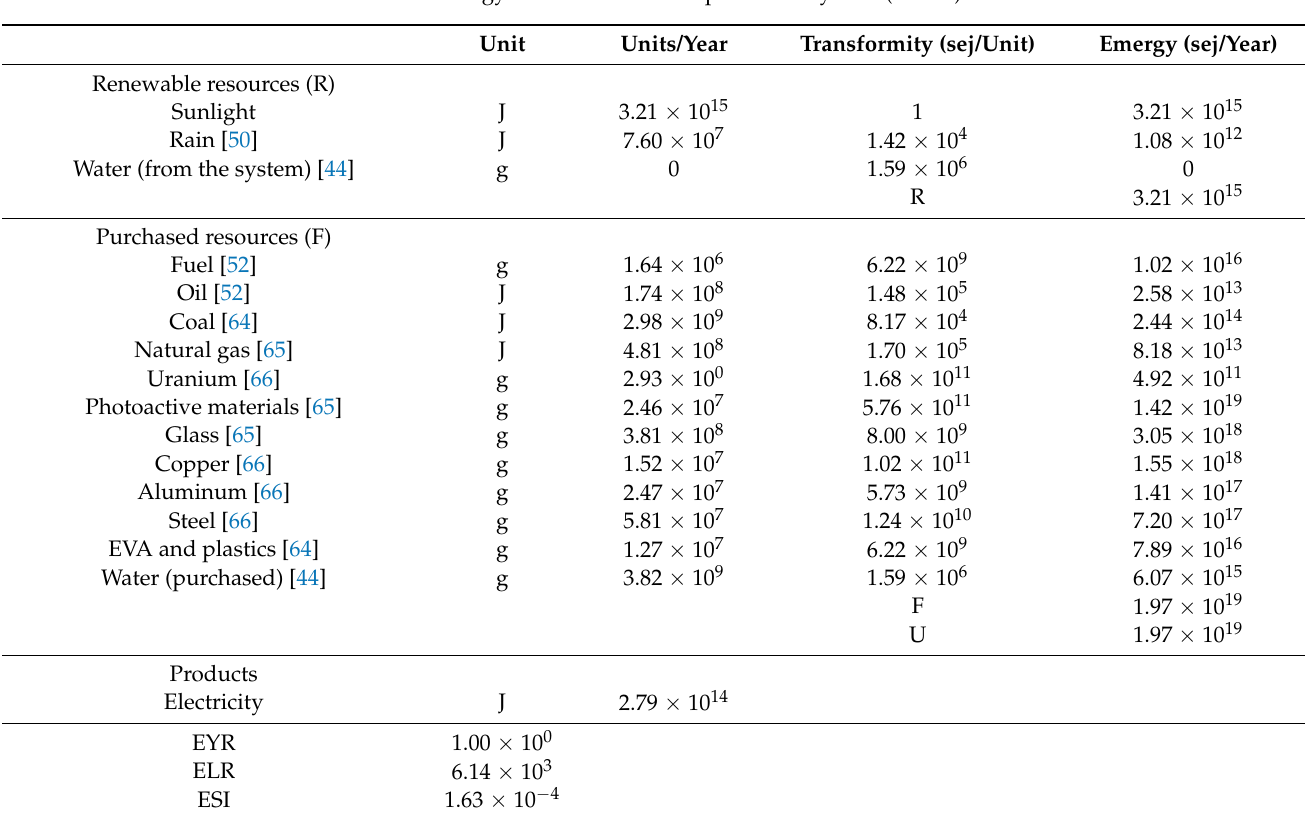
Table 9. Emergy calculation of solar power subsystem (before). Unit Units/Year Transformity (sej/Unit) Emergy